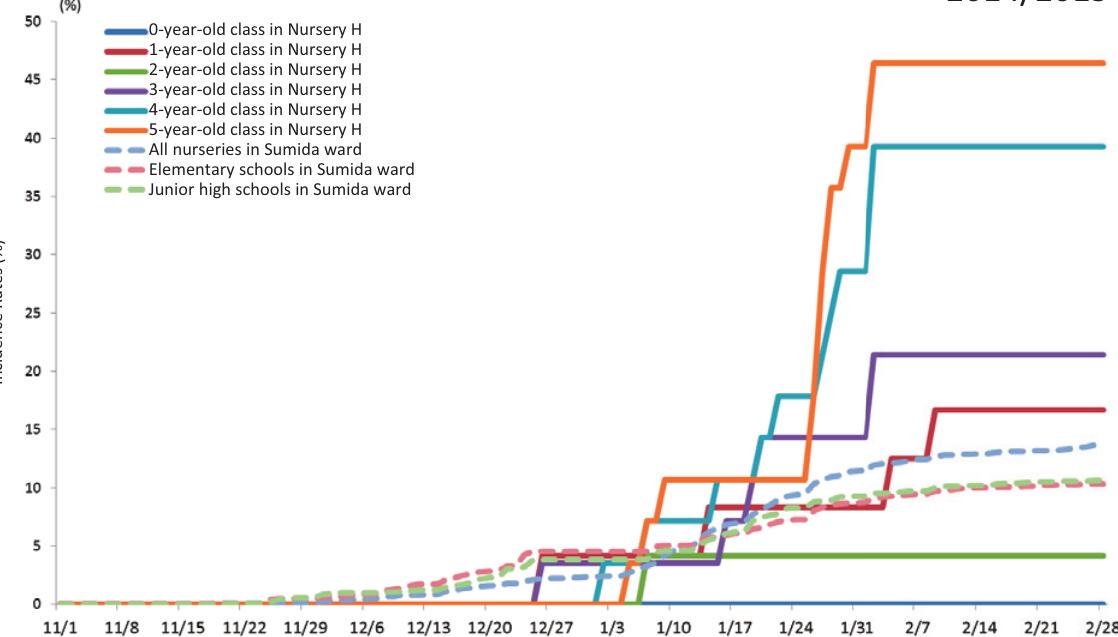
F i g . 3 D y namics of incidence rates of infl u enza b y a g e in N u rser y H compared w ith all n u rseries, and all elementar y and j u nior hi g h schools in S u mida W ard in the 2014/2015